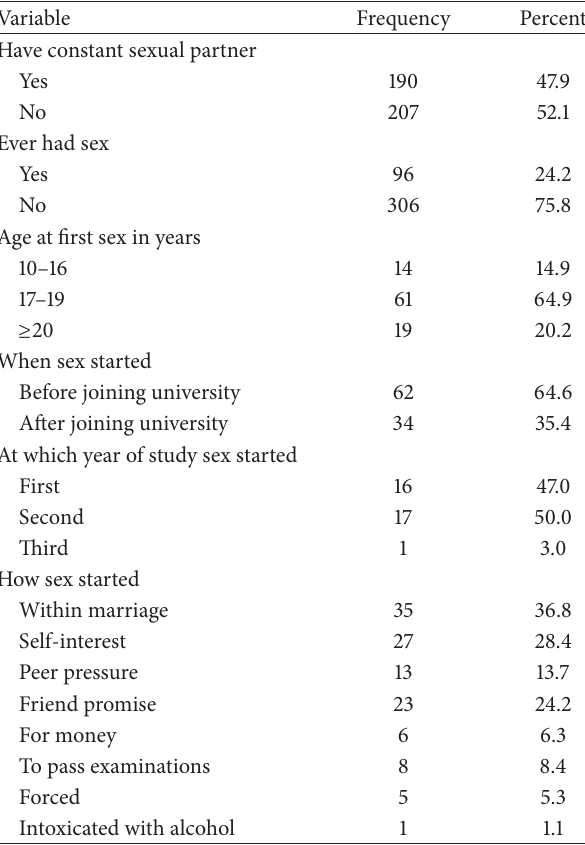
Table 2: Family educational status, mother and father living situation, and students’ living arrangement before joining university in Madawalabu University, southeast Ethiopia, April 2012.